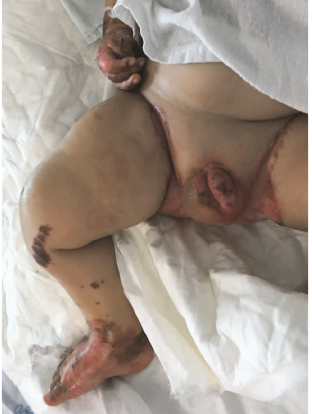
Figure 4: The patient became edematous with skin desquamation in the extremities and perianal region during the course of